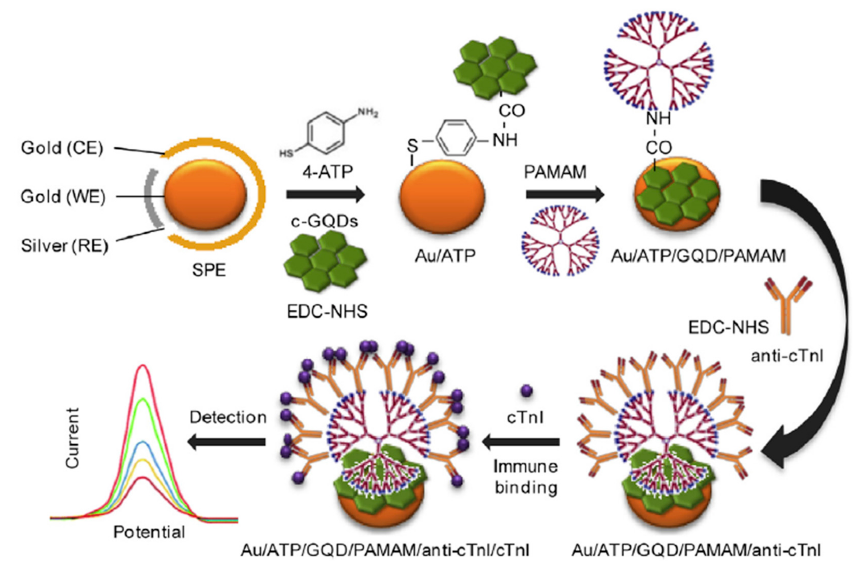
Figure 2. Electrochemical immunosensor constructed for the determination of cTnI involving the use of an Au/GQD/PAMAM nanohybrid electrode. Reprinted with permission from [10]. Copyright Elsevier, 2017.